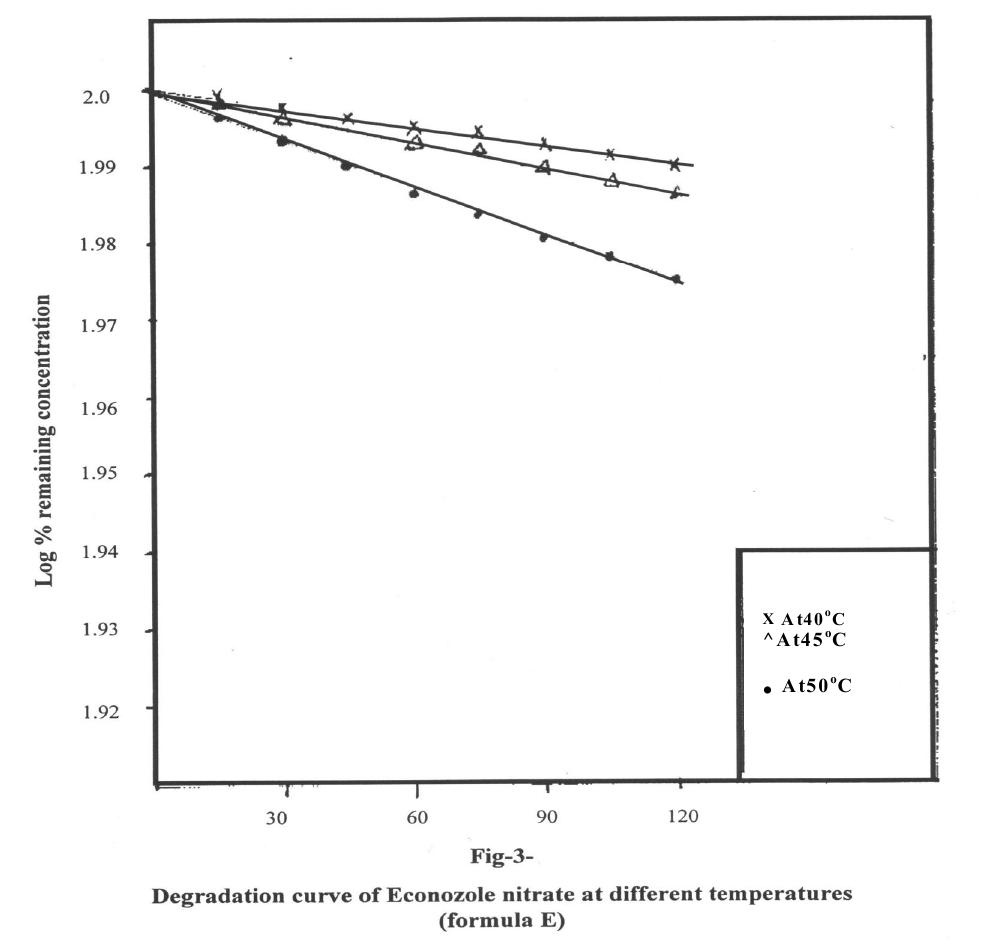
X At40 o C ^At45 o C . At50 o